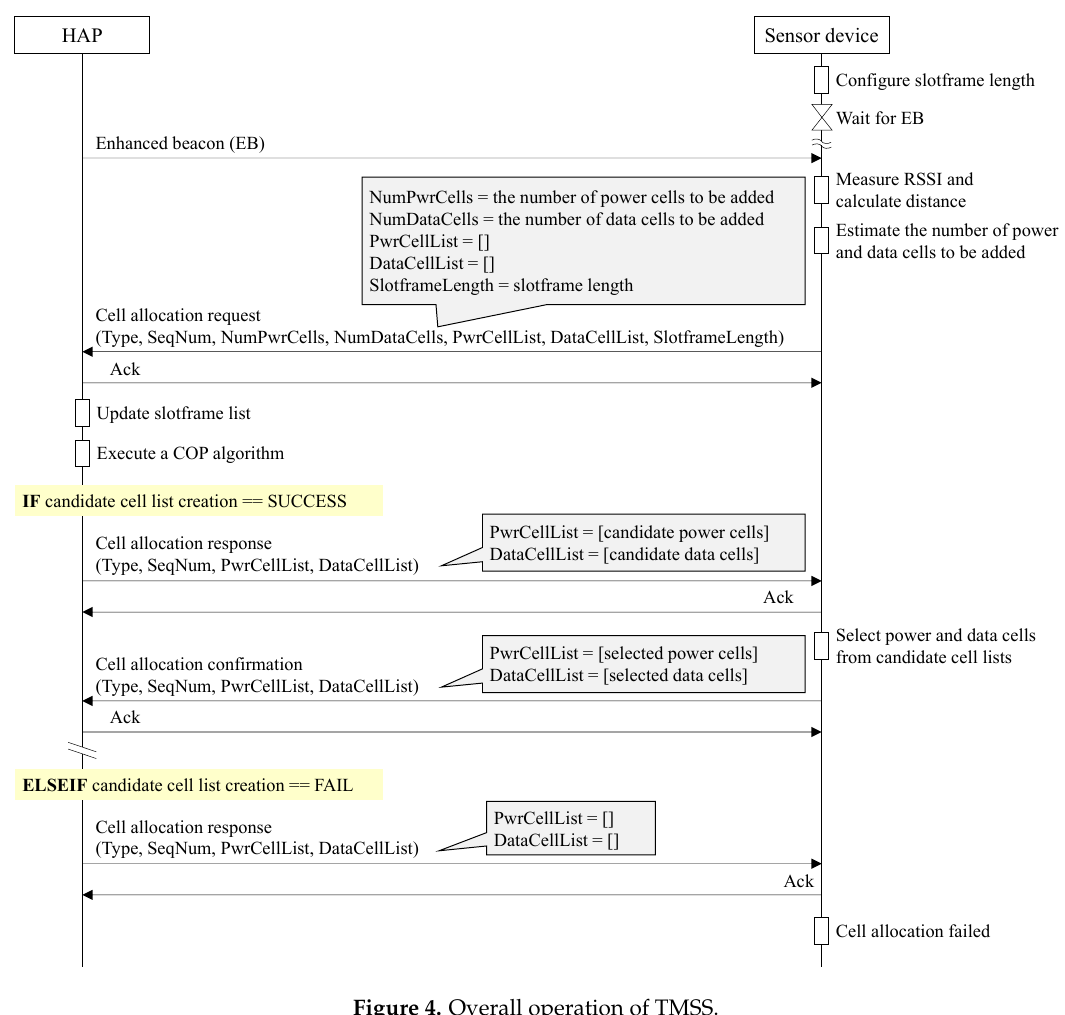
Figure 4. Overall operation of TMSS.